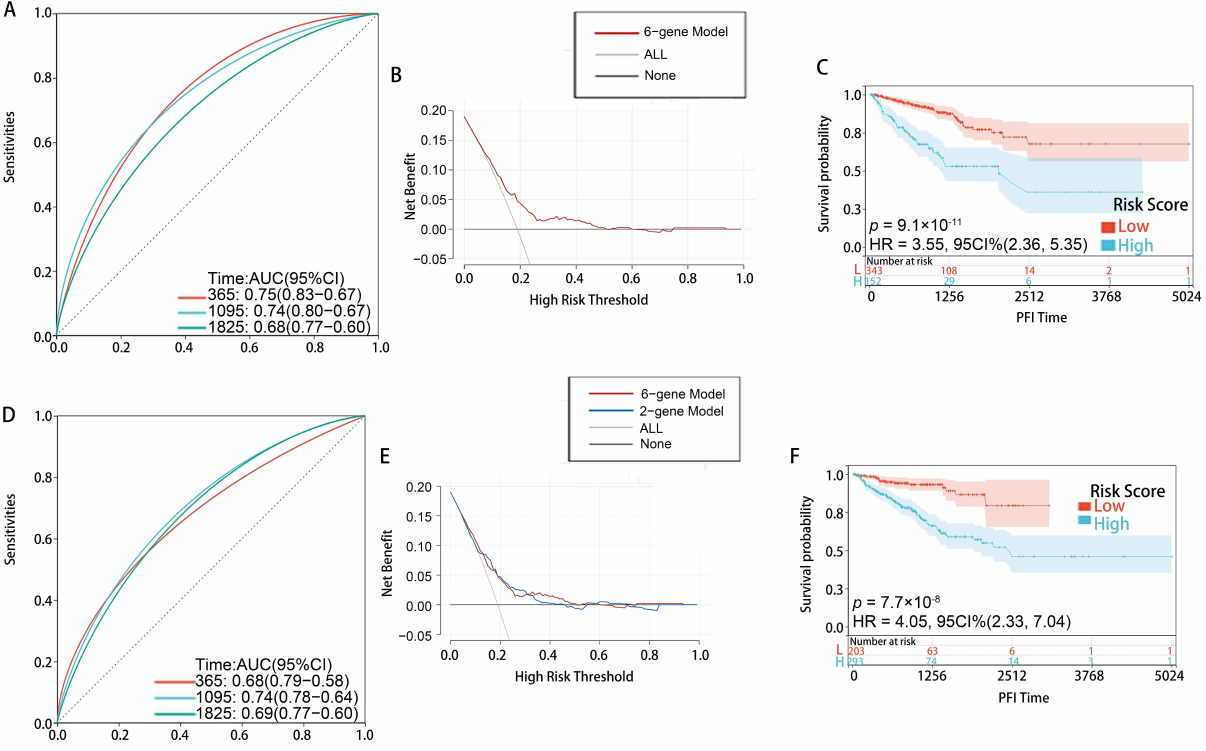
FIGURE 4. The validation and comparison of the 6-signature prediction model. (A) The ROC curves of the 6-signature prediction model. (B) The DCA curves of the 6-signature prediction model. (C) The correlation of risk score and prognosis status in the 6-gene signature prediction model. (D) The ROC curves of the 2-gene signature prediction model. (E) The DCA curves of the 2-gene signature prediction model. (F) The correlation of risk score and prognosis status in the 2-gene signature prediction